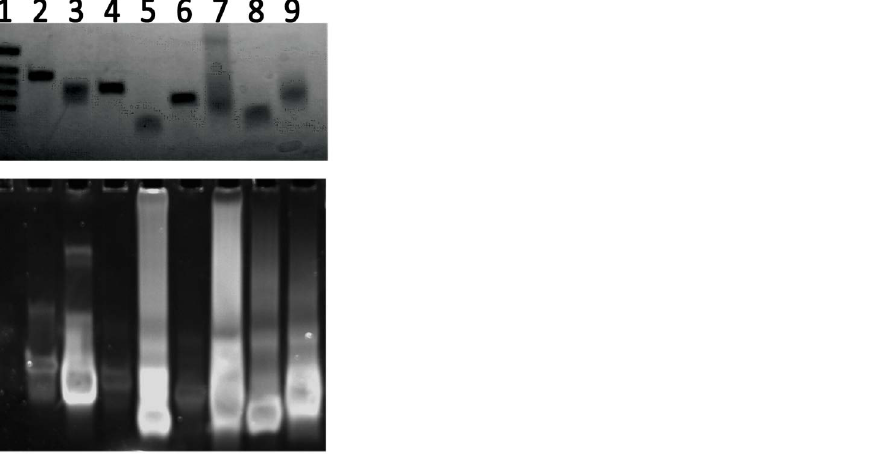
Figure 5. PAGE analysis of G4 oligonucleotides. (A). Non-denaturing 15% PAGE of G4 forming oligonucleotides run in the presence of 100 mM KCl, and visualised using UV shadowing. Lane 1: Oligo-dT size markers (size in bases indicated to left). Lane 2: G4MEST1A (mutant). Lane 3: G4MEST1 (wild-type). Lane 4: G4MEST2A (mutant). Lane 5: G4MEST2 (wild-type). Lane 6: G4MEST3A (mutant). Lane 7: G4MEST3 (wild-type). Lane 8: G4MEST2M (methylated). Lane 9: G4MEST3M (methylated). (B). Same gel stained with SYBR Safe, a dsDNA specific, intercalating dye. Lane numbering as above. Note the oligo-dT size markers are single stranded and therefore not